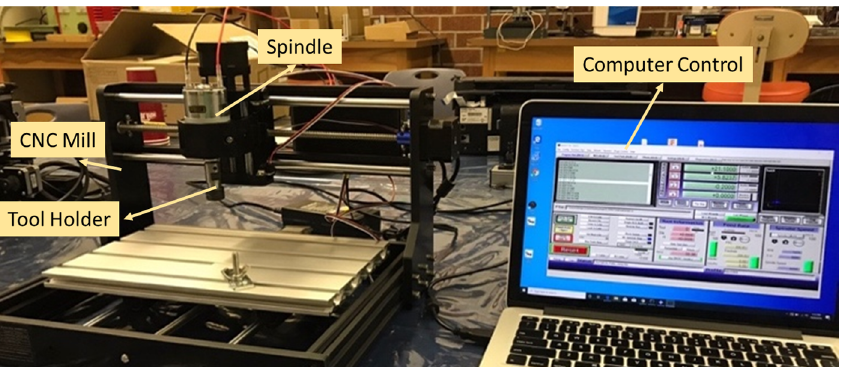
Figure 1. CNC Mill—cutting parameters controlled through computer